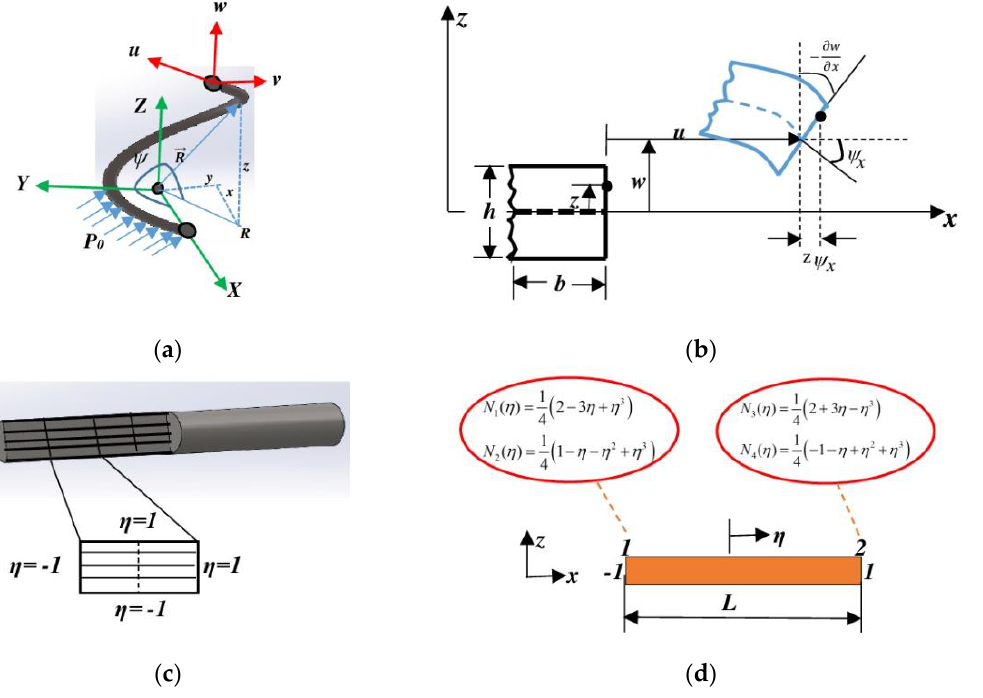
Figure 3. Finite element model: ( a ) helical curve under radial load in a local coordinate system, ( b ) kinematics of nonlinear Euler – Bernoulli beam, ( c ) layered beam element, and ( d ) beam element in ( b ) kinematics of nonlinear Euler–Bernoulli beam, ( c ) layered beam element, and ( d ) beam element in the natural coordinate system. the natural coordinate